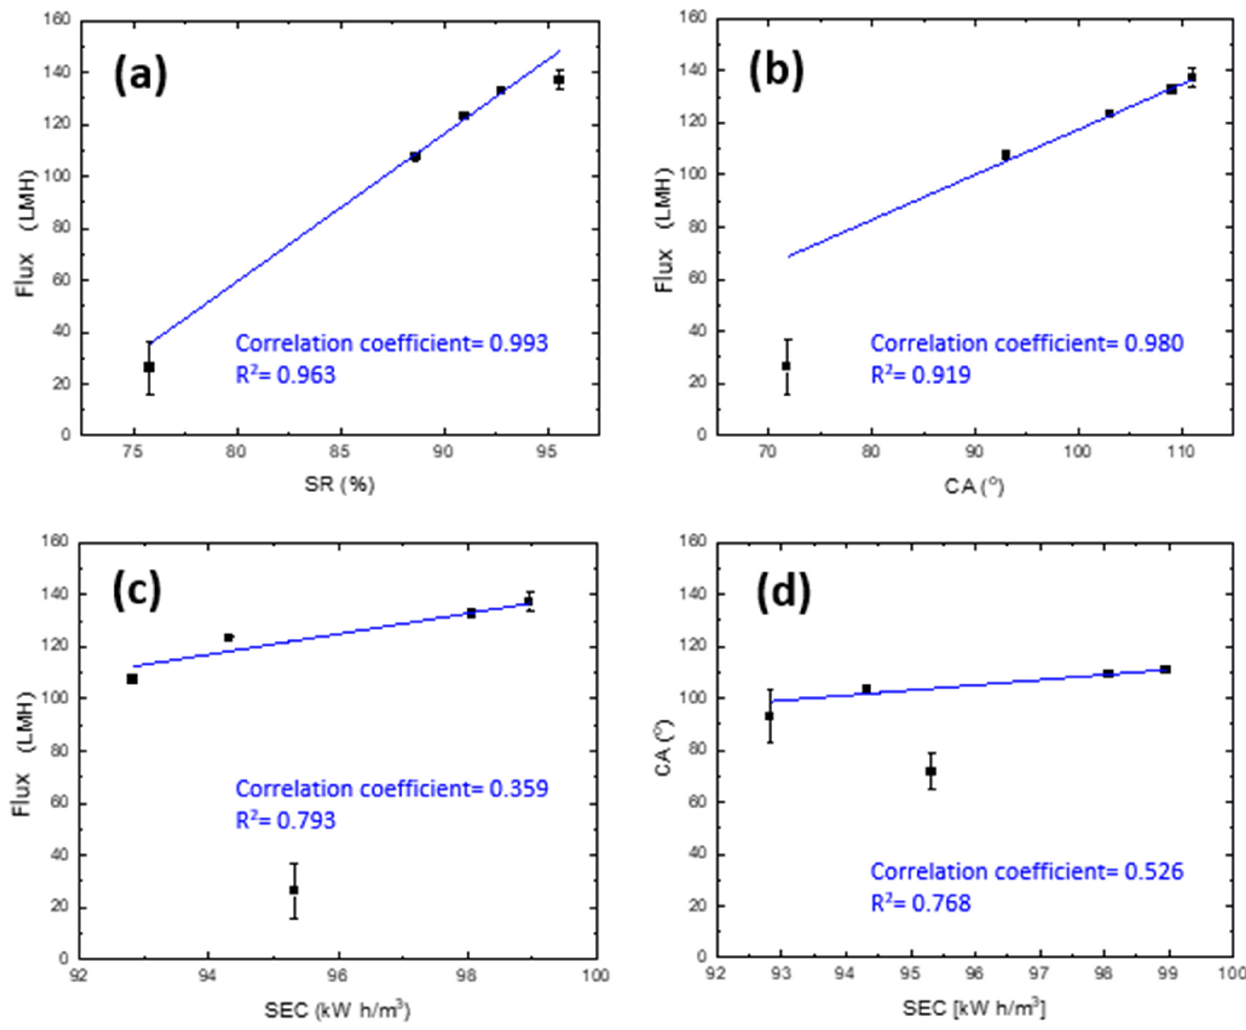
Figure 14. The correlations of the calculated water flux with ( a ) salt rejection, ( b ) contact angle, ( c ) specific energy consumption, and ( d ) the correlation of the contact angle with the specific energy consumption.